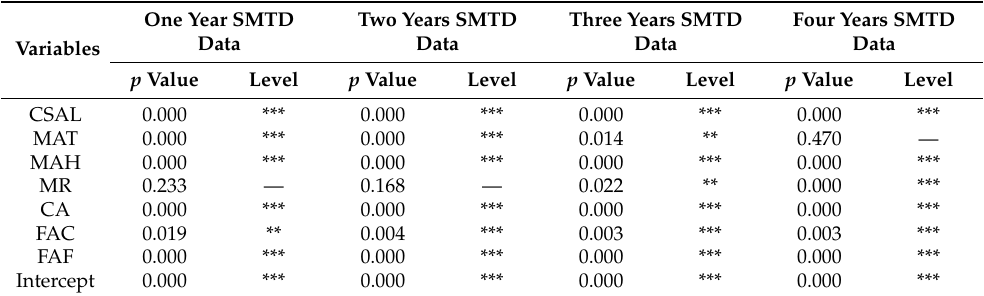
Table 9. Comparison of the variable significance level of the random-effects model based on different time scales of SMTD